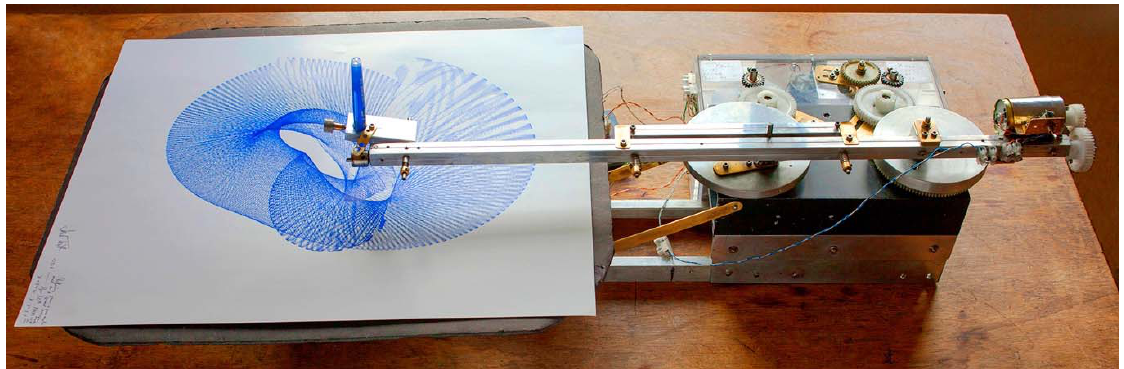
Figure 2. Hommage to Henry machine referred to below as HHM. Mathematics 2019 , 7 , 86